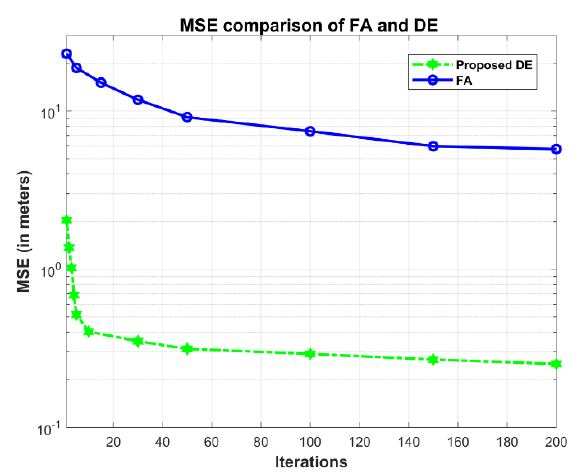
Figure 5. Effect on MSE with increase in iterations.